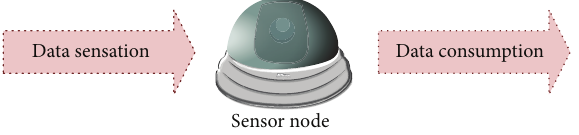
Figure 3: Sensor with the data sensation/consumption